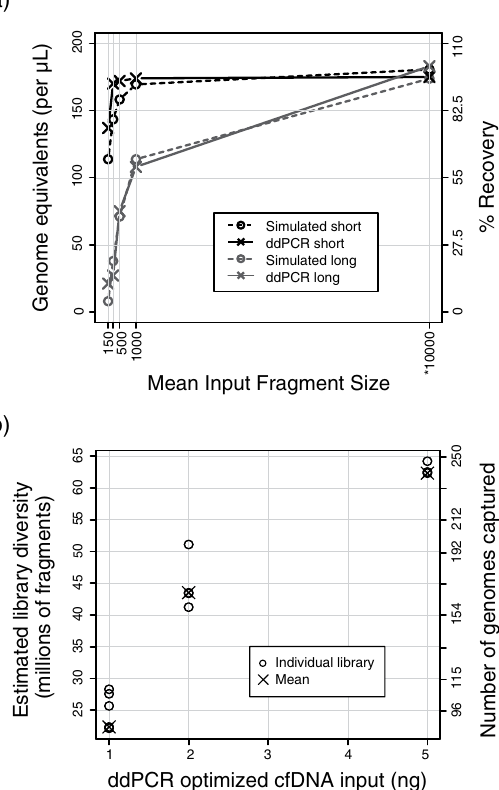
Figure 2. Evaluation of ddPCR assay performance. ( a ) Comparison of ddPCR measurements with expected results when using control DNA of known fragment size as template. Solid lines with crosses show measured ddPCR results. DNA concentration was held constant for this experiment, isolating the effect of fragment size on final measurements. Dotted lines with circles show simulated data, generated using the exponential distribution with period set to fragment size. * Simulated data was generated assuming 10,000 bp fragments, a much larger period compared to the PCR amplicon sizes used here. Corresponding ddPCR measurement was performed on intact genomic DNA (without sonication). ( b ) Evaluation of sequencing library diversity obtained with cfDNA input amounts measured using the ddPCR assay. The first y-axis on the left shows projected diversity of the library in millions of unique fragments. On the second y-axis (right), library diversity has been converted into number of genome equivalents, by calculating the quotient between the projected diversity and fragments expected per haploid genome. Assuming 44 Mb exome captured region and 170 bp fragment size, we expect ~0.26 million fragments per haploid genome. 5, 4, and 3 individual libraries were prepared for 1, 2, and 5 ng cfDNA input respectively. These data are also listed in Supplemental Table